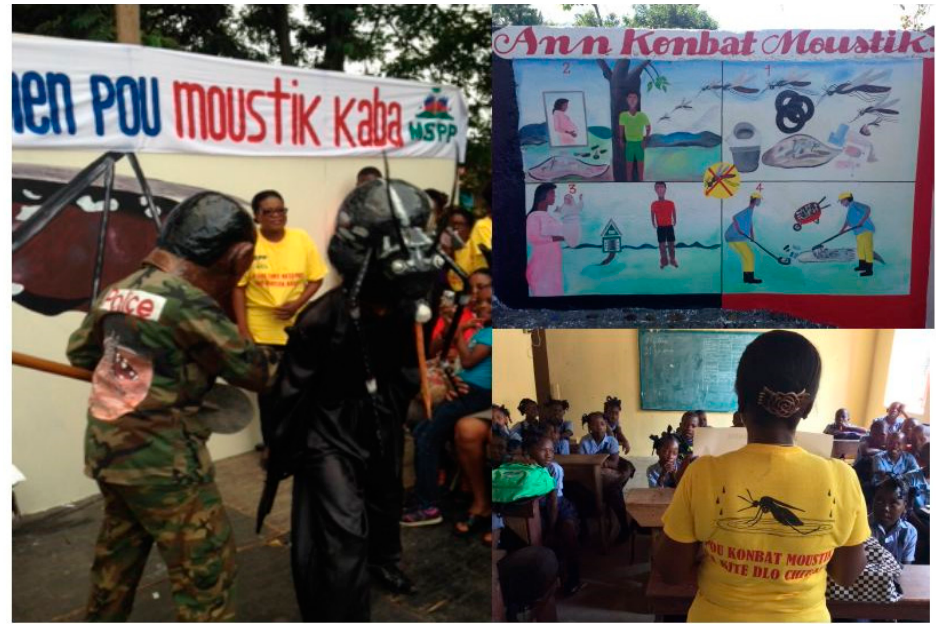
Figure 3. Mosquito mascot performance ( left ); a large painted mural from the art competition ( top right ); and a photo of the school-based program ( bottom right ).